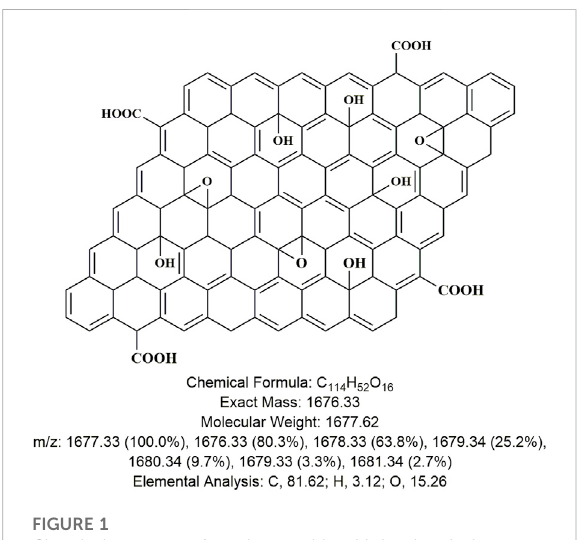
FIGURE 1 Chemical structure of graphene oxide with its chemical analysis redrawn using ChemDraw ultra 12 (Xiang et al.,